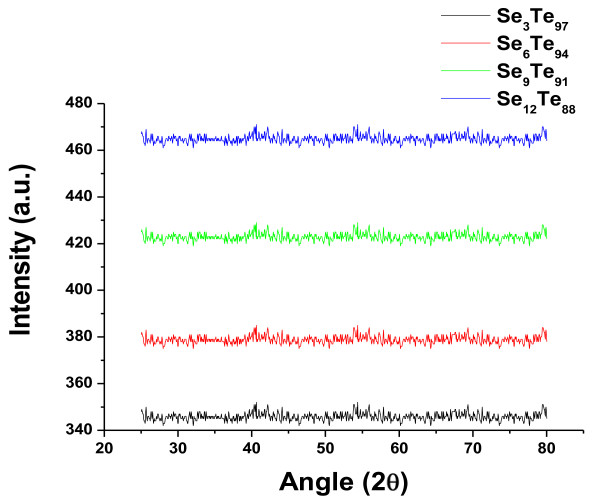
XRD pattern of a-Se

x

Te100-x.